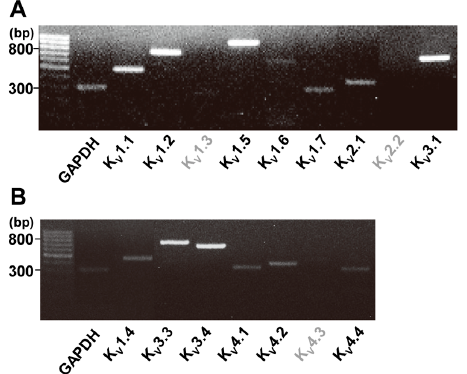
Figure 1. Identification of two types of voltage-gated K + (K V ) channels in human cardiac fibroblasts by reverse transcription polymerase chain reaction (RT-PCR). ( A ) Strong gene expression was shown for K V 1.1, K V 1.2 K V 1.5, and K V 3.1 for delayed rectifier K + (I K ) channels and ( B ) K V 3.3 and K V 3.4 for transient outward K + (I to ) channels . Weak expression was observed for K V 1.6, K V 1.7 and K V 2.1 (for I K ) and K V 1.4, K V 4.1, K V 4.2, and K V 4.4 (for I to ). Glyceraldehyde 3-phosphate dehydrogenase (GAPDH)